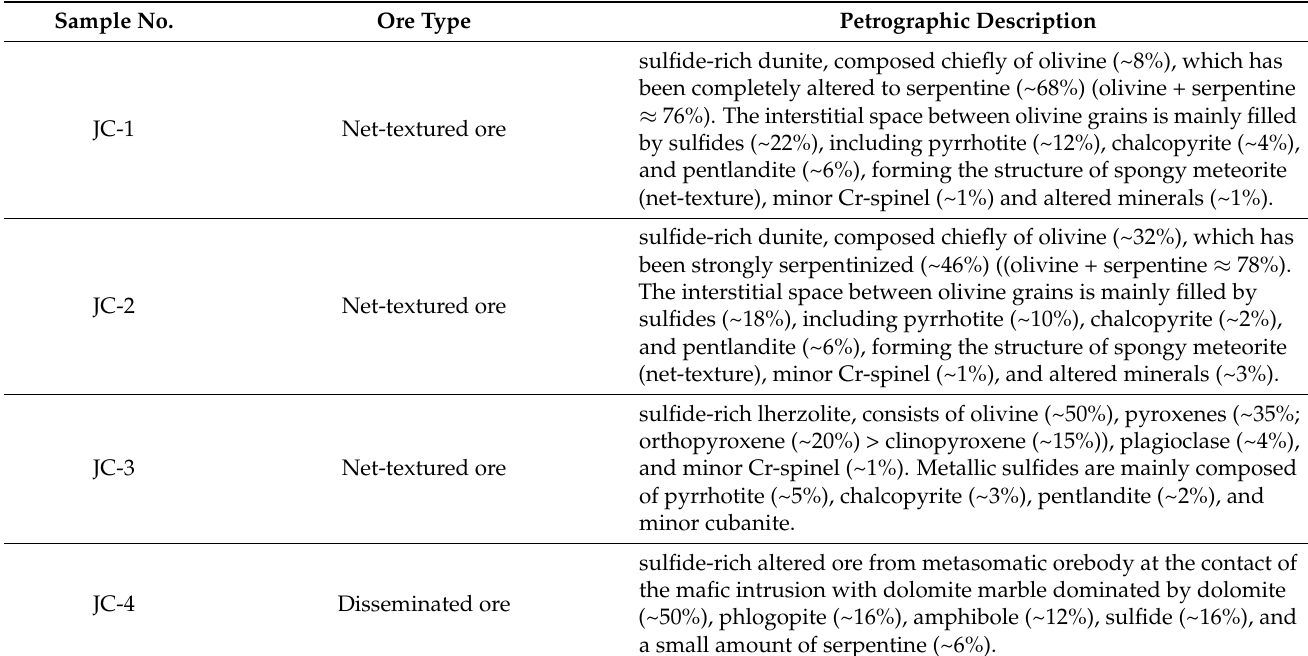
Table 1. Petrography of studied ore samples from the Jinchuan deposit. Sample